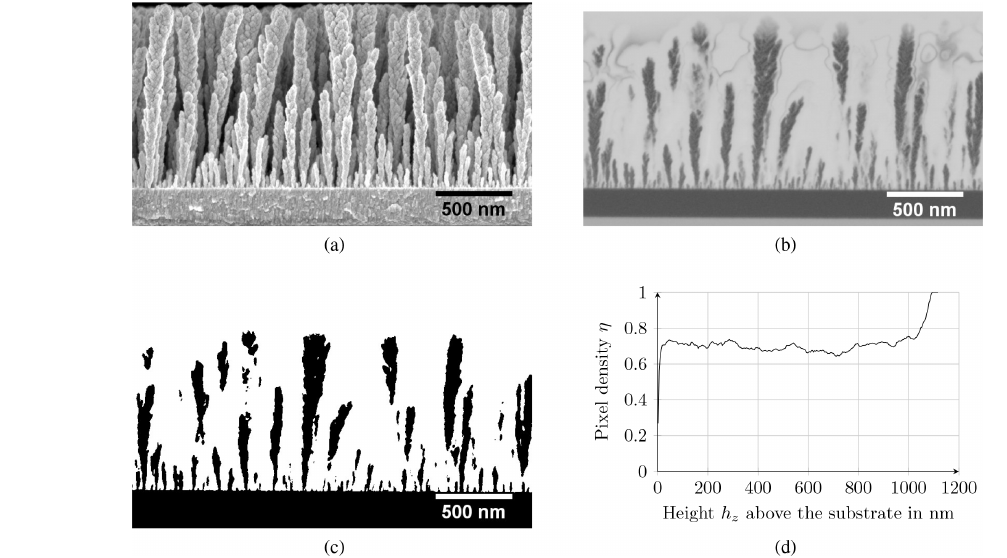
Figure 7. Sample preparation to determine the pixel density dependent on the height above the substrate. (a) SEM image of the sample, (b) SEM image of the FIB sliced sample (inverted), (c) segmented FIB-SEM image, and (d) calculated pixel density from an FIB-SEM image.